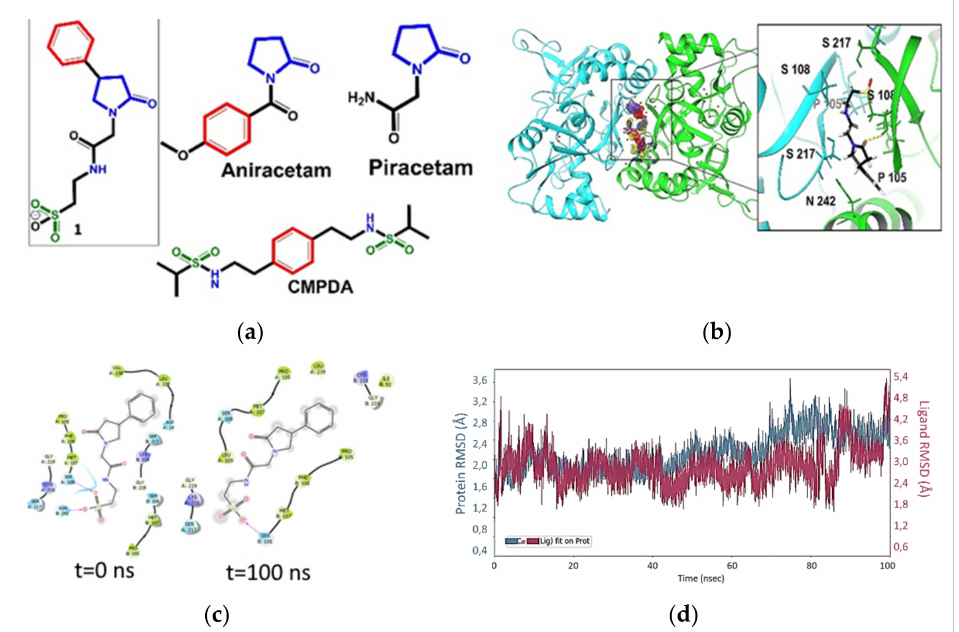
Figure 7. Binding of PAM of AMPA-receptor in the active site S1S2: ( a )—comparison of structural features of the test compound 1- R with aniracetam and CMPDA; ( b )—localization of PAM binding site: donor–acceptor and hydrophobic regions are shown as blue, red, and yellow, respectively, and the location of compound 1- R in the PAM binding site: water molecules are shown as red balls, hydrogen bridges as a yellow dashed line; ( c )—results of molecular simulations for 100 ns: changes in packing of the compound 1- R in the initial and final states; ( d )—RMSD indicators of the considered